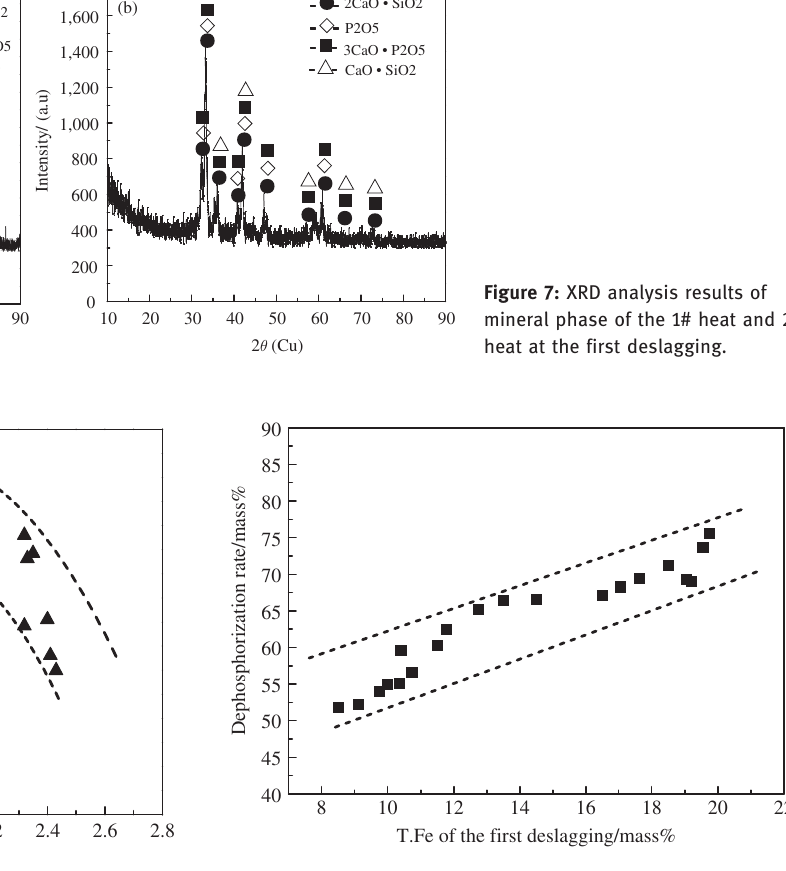
Figure 8: Effect of the slag basicity in slag on the dephosphorization rate at the first deslagging.